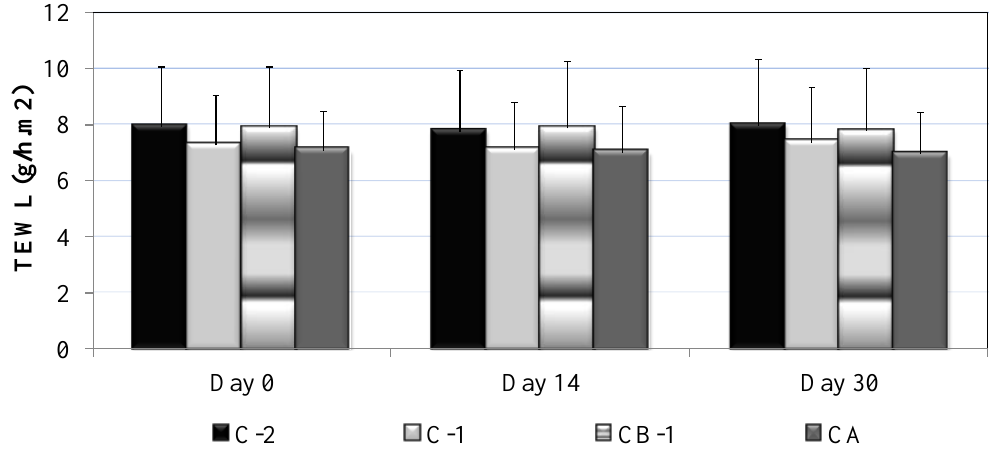
Figure Transepidermal water loss (TEWL) over 30 days of treatment with different cream formulations: cream with concentrated thermal water 2:1 (C-2), cream with thermal water (C-1), cream with laboratory water (CB-1), and evaluation of skin without cream (Control area). (mean ± SD, n = 12).